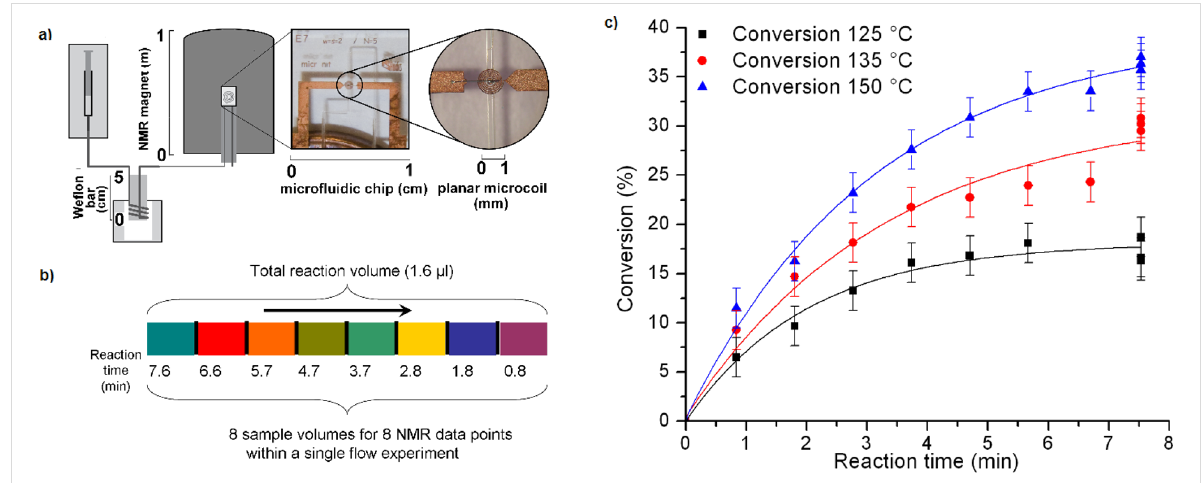
Figure 12: (a) Experimental setup for the reaction. (b) Reaction samples analyzed independently by NMR. (c) Plot of conversion vs time at different temperatures determined by NMR. All of the data points for a certain temperature were collected from a single flow experiment. Reproduced with permission from reference [48]. Copyright 2010 The Royal Society of